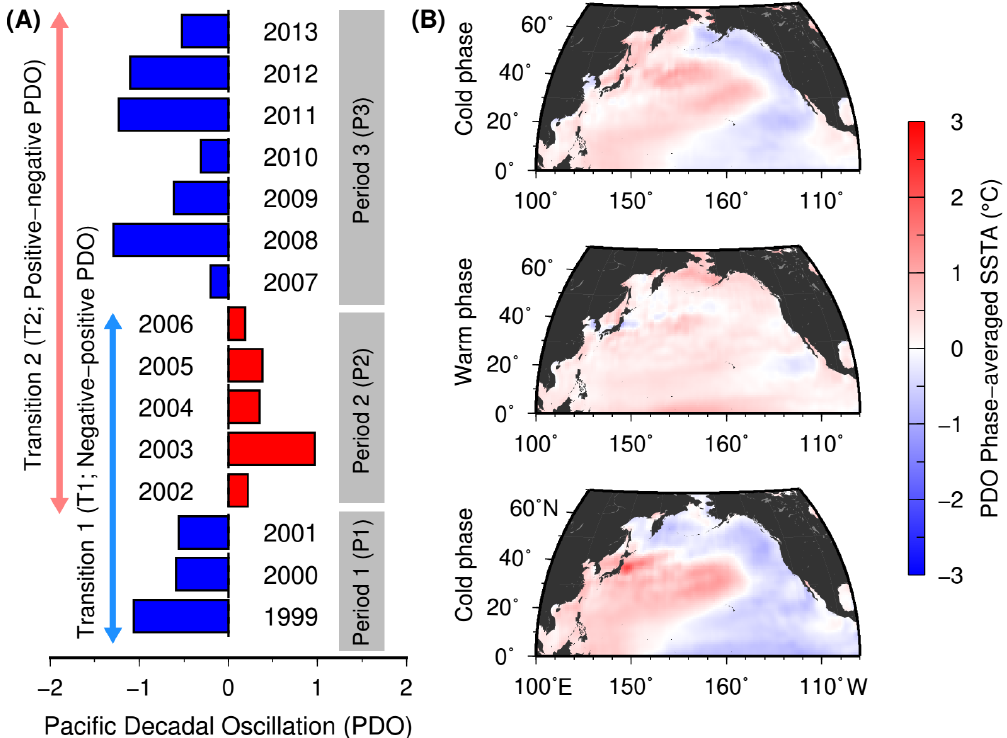
Figure 2. ( A ) Annual-averaged index of Pacific decadal oscillation (PDO) used to identify the